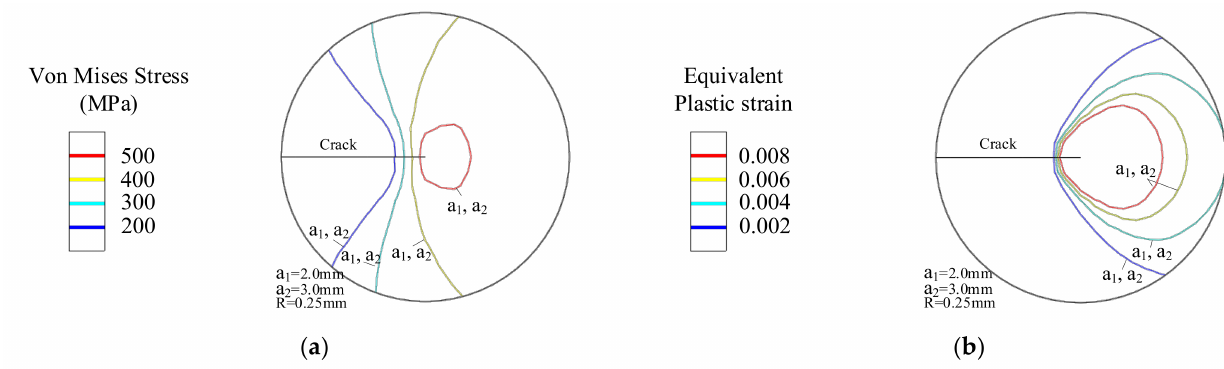
Figure 13. G x = 0 crack tip mechanical field. ( a ) Von Mises stress contour and ( b ) Equivalent plastic strain